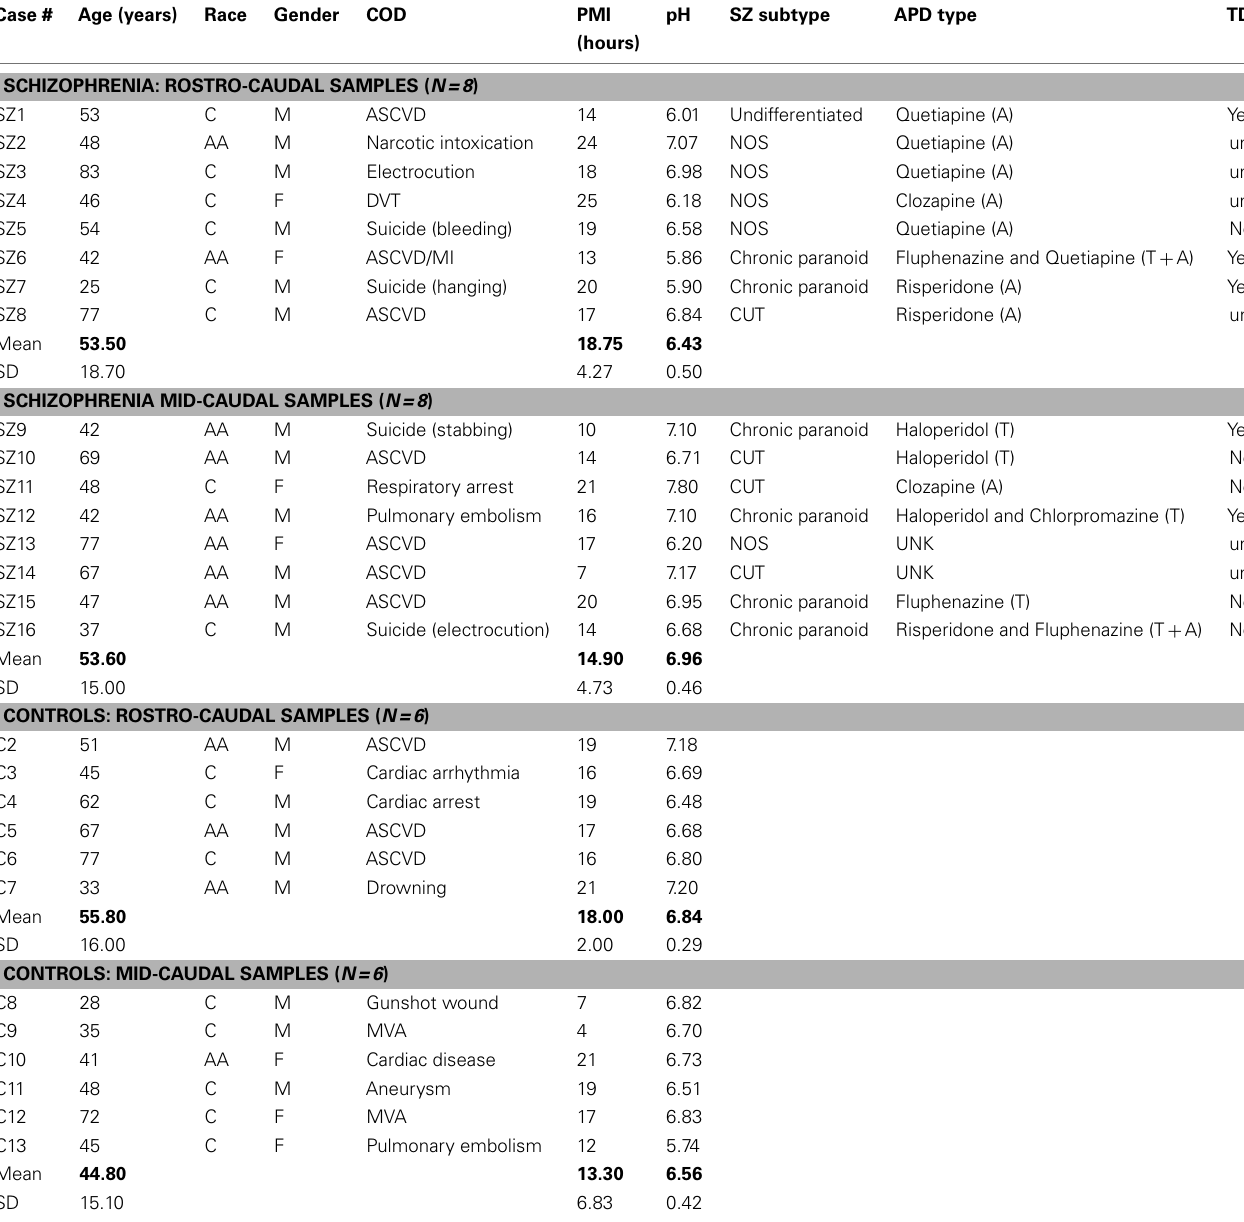
Table 2 | Demographic table and clinical data second postmortem